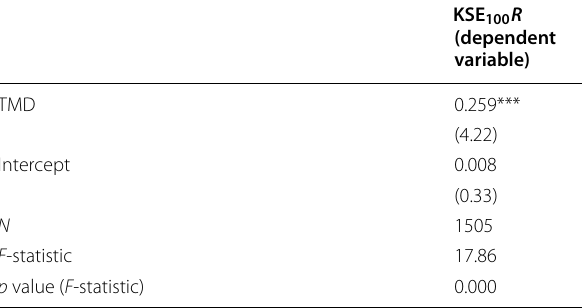
Table 9 Linear regression on overall sample